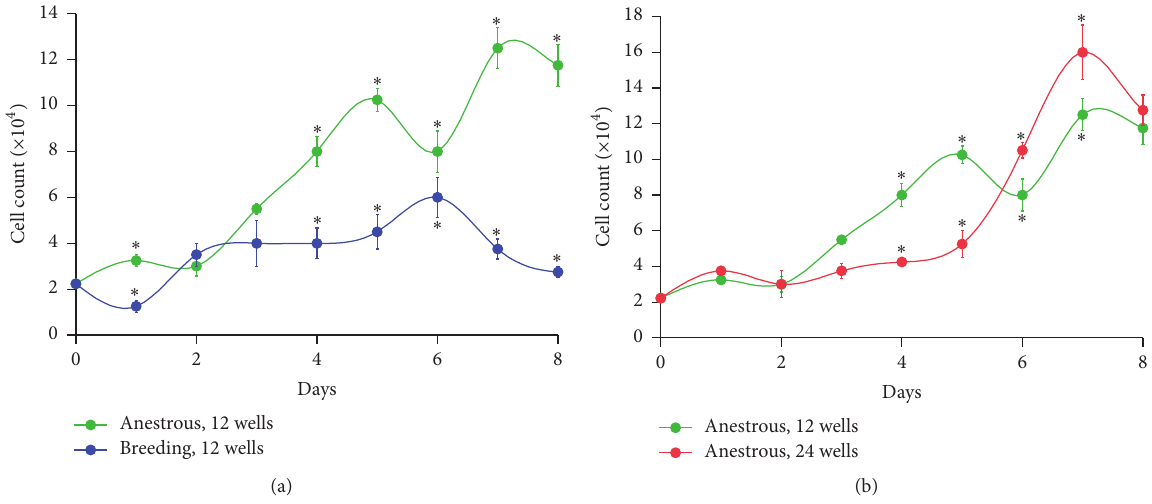
Figure 3: Comparison of growth curves of goat endometrial mesenchymal stromal stem cells after seeding of 2.2 × 10 4 cells (a) in 12-well culture plates between anestrous and breeding stage and (b) between 12-well and 24-well culture plates in anestrus